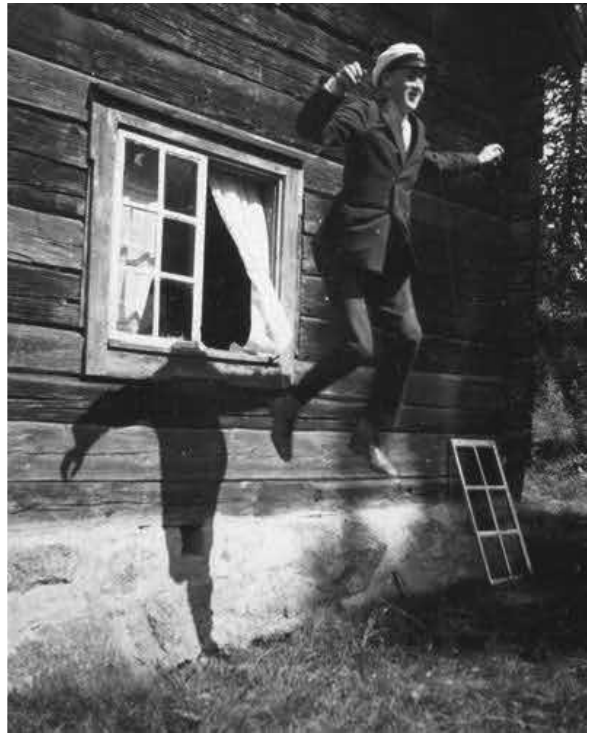
Figure 1: “Off-stage” picture of unknown student of folklife researcher Sigurd Erixon (1888–1968) during field research in the Swedish countryside in the early twentieth century (see Gustavsson 2014, Ethnologia Europaea 44:2). (Photo: From the Sigurd Erixon Archives, Linköping